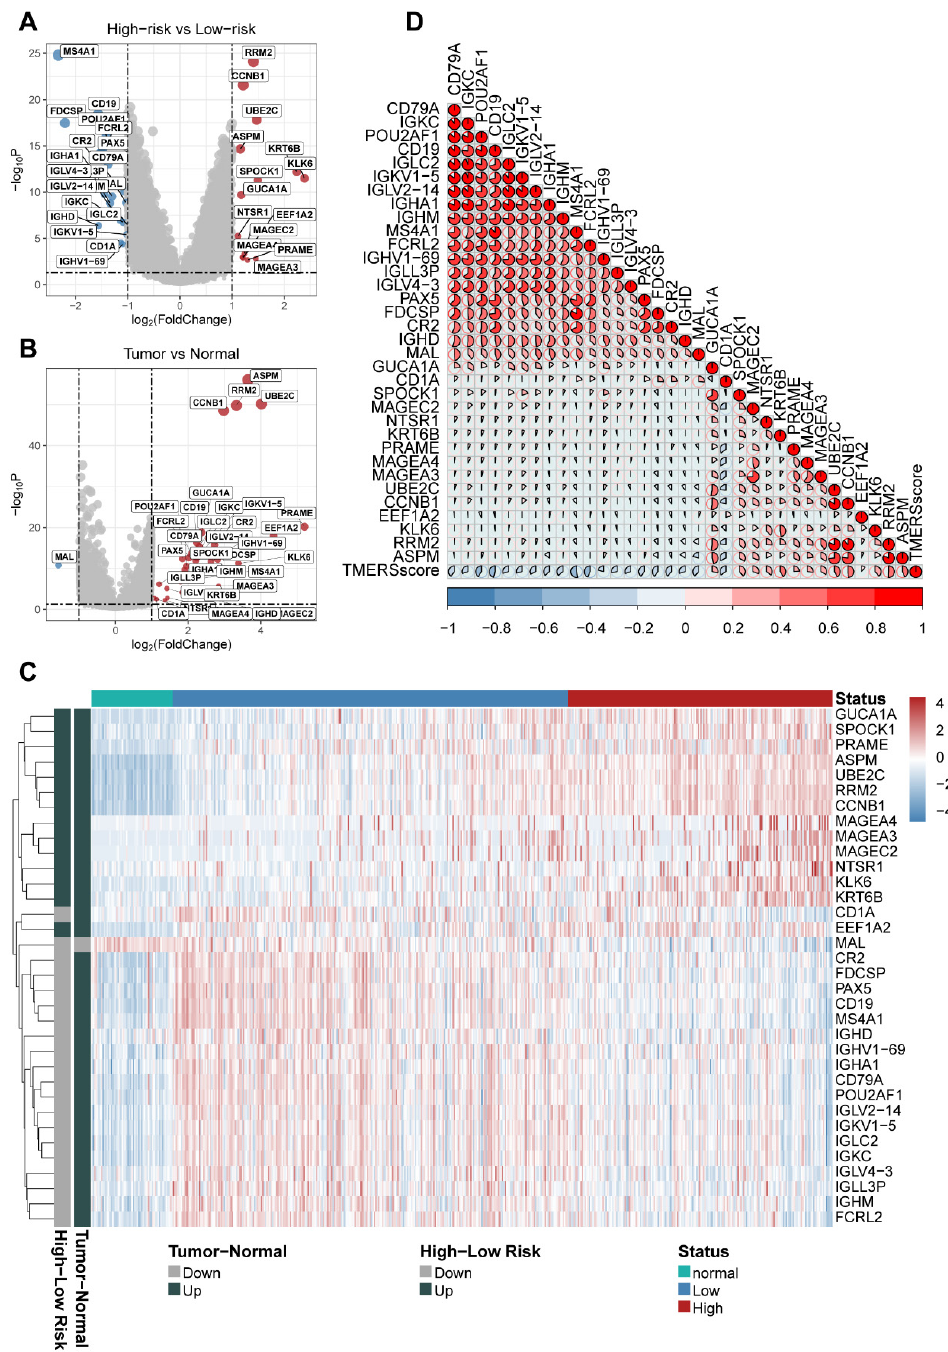
Figure 4. Expression patterns of DEGs contained in the eight selected TMERSs in different subgroups. ( A ) and ( B ) are volcano plots showing the differential expression status of DEGs in tumors compared to normal and in the high-risk group compared to the low-risk group, respectively. ( C ) Heatmap of the expression of DEGs between different subgroups. ( D ) Correlation plot showing the correlation between TMERSscore and the expression of DEGs.